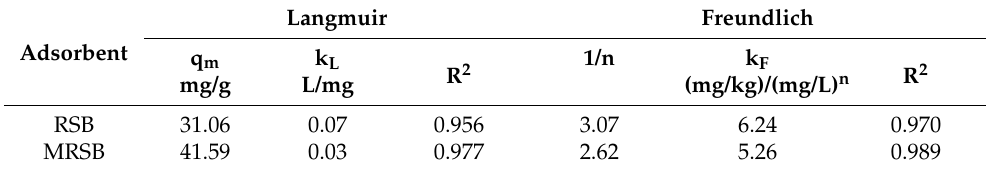
Table 2. The Langmuir and Freundlich isotherm parameters for SO adsorption onto MRSB and RSB.